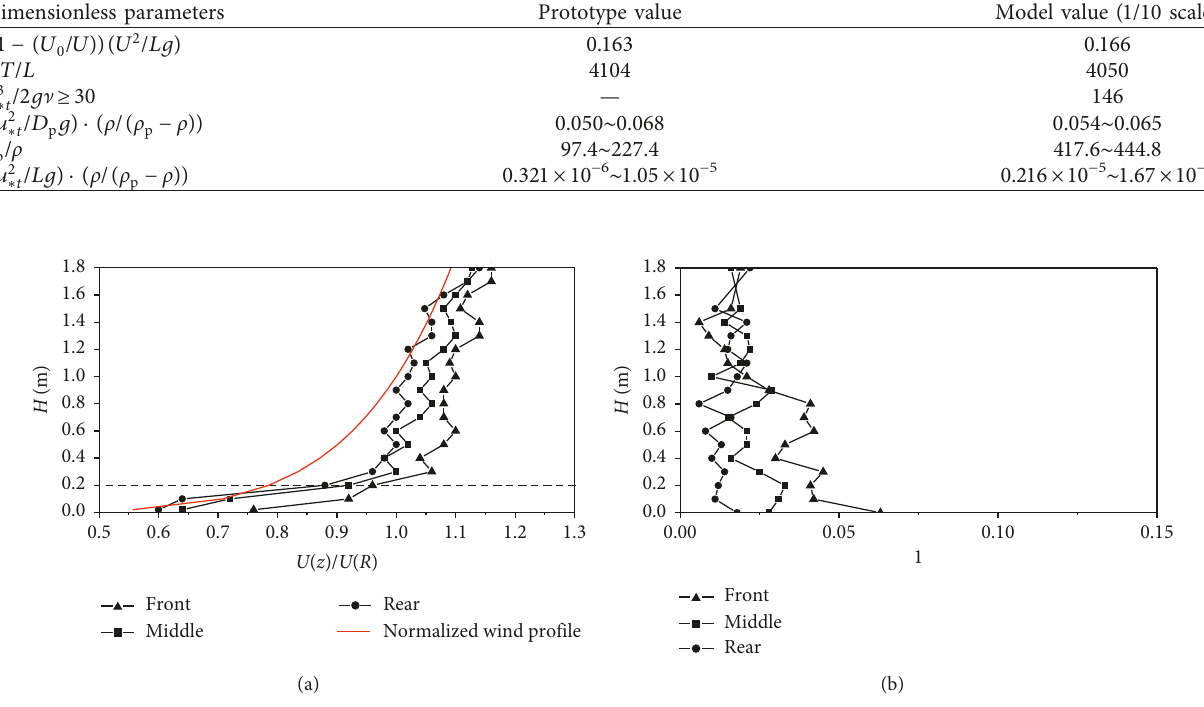
Figure 7: Variations in normalized mean (a) wind speed and (b) intensity of turbulence with height.